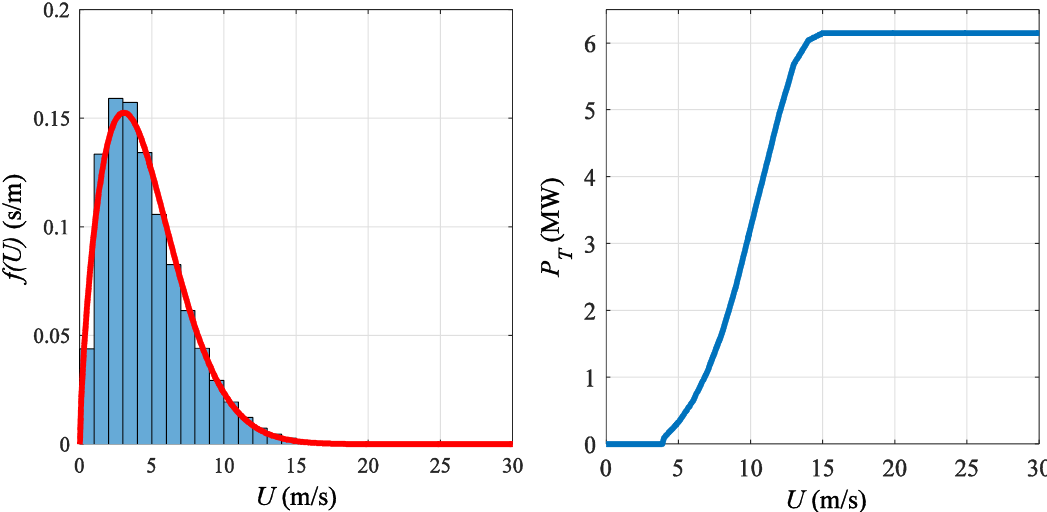
Figure 2. Example of a wind speed distribution and the corresponding Weibull fit for a site in the area of the Port of Avilés ( left ) and the power curve of the 6.2M152 offshore wind turbine ( right